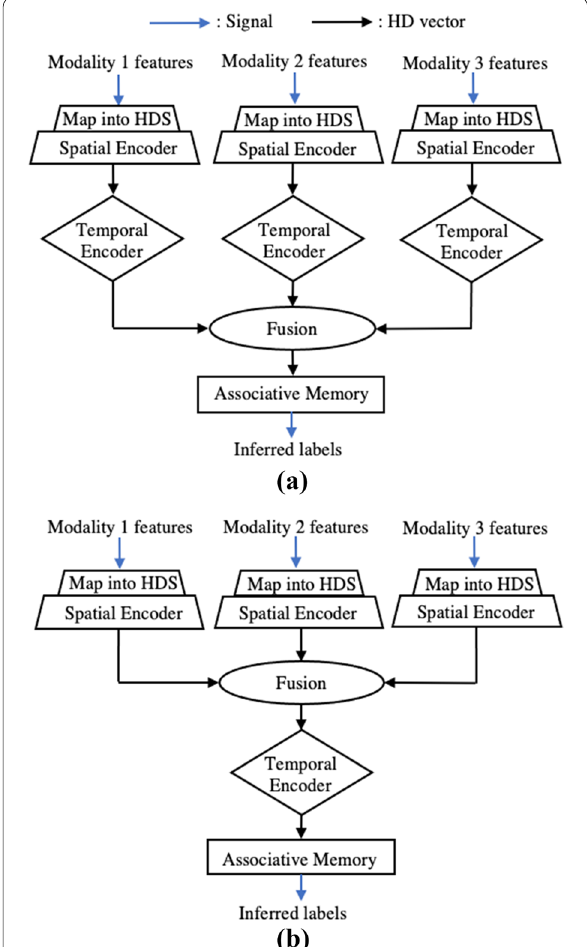
Fig. 3 HDC a late fusion and b early fusion architectures for a three-modality emotion recognition system. The late fusion architecture fuses after the temporal encoder, resulting in 3 parallel temporal encoders—one per modality. In comparison, the early fusion architecture fuses before the temporal encoder, resulting in only 1 temporal